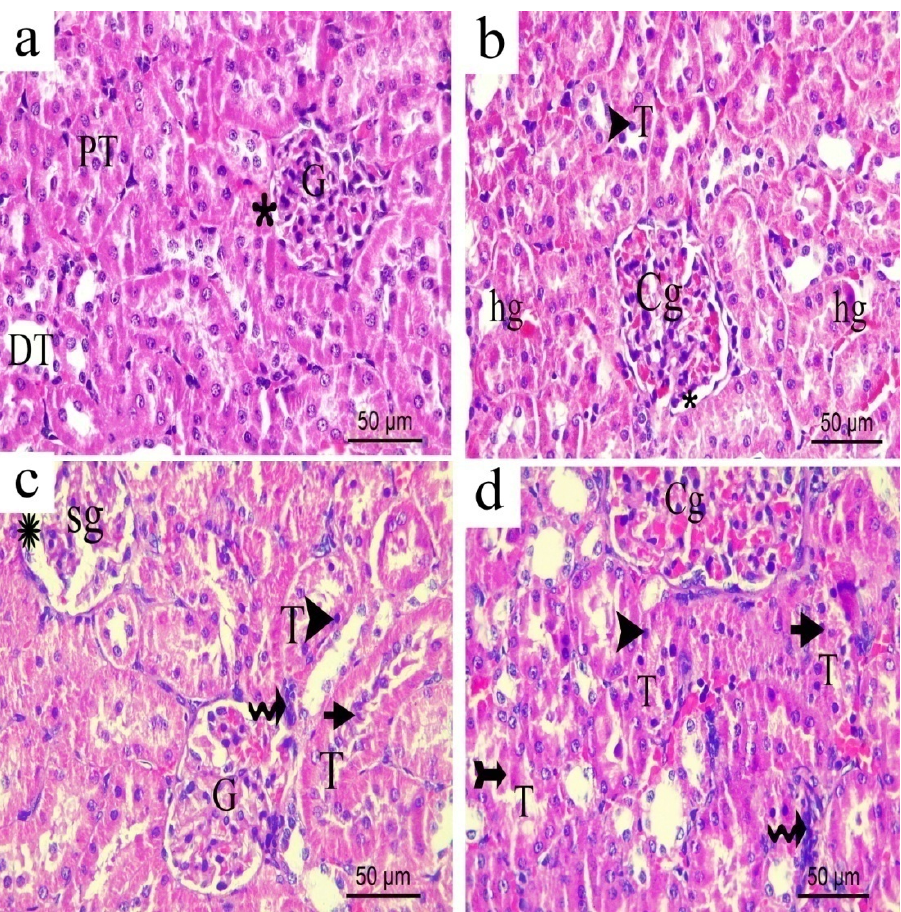
Figure 18. Representative photograph of renal cortex sections of the different groups. ( a ) sham; ( b ) CCI; ( c ) H. campechianum flower extract (p.o., 200 mg/kg); ( d ) H. campechianum flower extract (p.o., 400 mg/kg). Asterisk, arrow and arrowhead illustrate bowman space the dark, stained nuclei and infiltrating cells, respectively. C, peritubular capillaries; Cg, congested glomeruli; DT, distal convoluted tubule; E, exfoliated cells; G, glomerulus; PT, proximal convoluted tubule; T, affected tubule. Scale bar, 50 μm × 400.